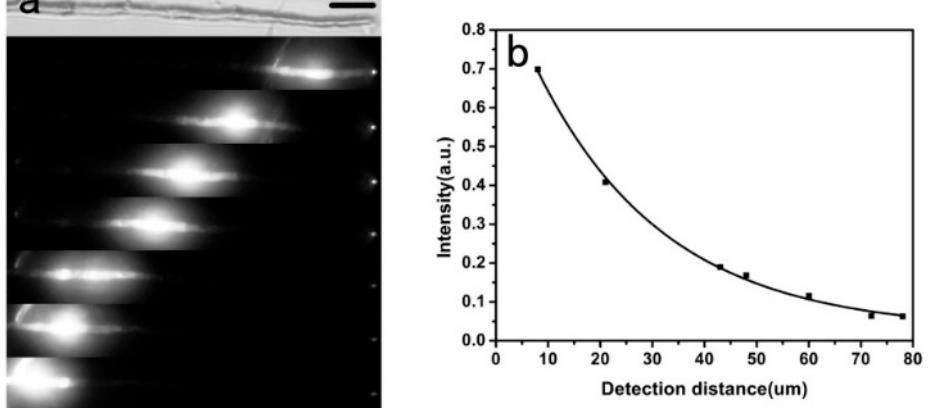
Figure 5. ( a ) Fluorescence microscopy images collected upon different excitation positions of the same microtube. ( b ) I tip / I body versus propagation distance and the exponential fit ( I tip and I body are shorted for the fluorescence intensity from the tip and the body of the microtube, respectively, the whole Figure 5 was reprinted with permission from Hu et al. [43]).